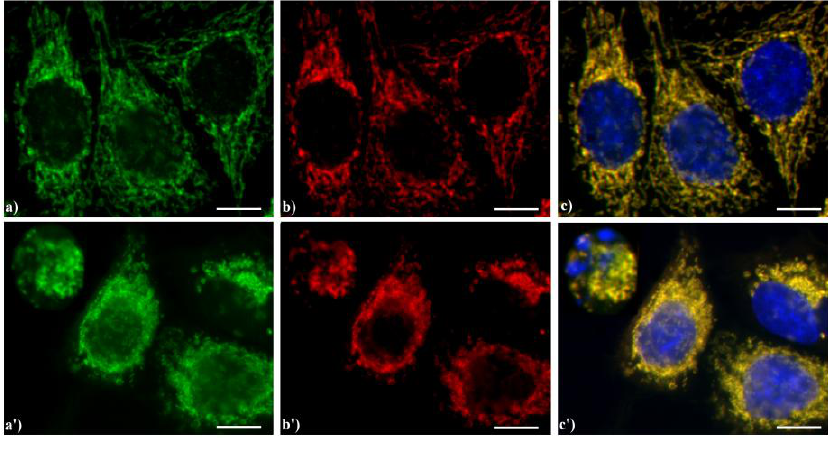
Figure 6. Double immunocytochemical detection of Apoptosis Inducing Factor (AIF) and mitochondria. ( a – c ) control HeLa cells; ( a' – c' ) cells treated with 10 μM etoposide for 20 h. Cells on coverslips were fixed and incubated with polyclonal anti-AIF antibody ( a , a' ) (dilution 1:50 in PBS; Cell Signaling Technology) and then with an Alexa 488-conjugated anti-rabbit antibody (1:200 in PBS, green fluorescence; Molecular Probes). Mitochondria ( b , b' ) were labeled with a mouse monoclonal antibody recognizing the mitochondria- specific mtHSP70 (1:50 in PBS; Alexis, Vinci Biochemicals) and then with an Alexa 594-conjugated anti-mouse IgG antibody (1:200 in PBS, red fluorescence; Molecular Probes). DNA was counterstained with Hoechst 33258 (blue fluorescence). The yellow staining in ( c , c’ ) reveals that mitochondria (red fluorescence) and AIF (green fluorescence) colocalize. Scale bar: 20